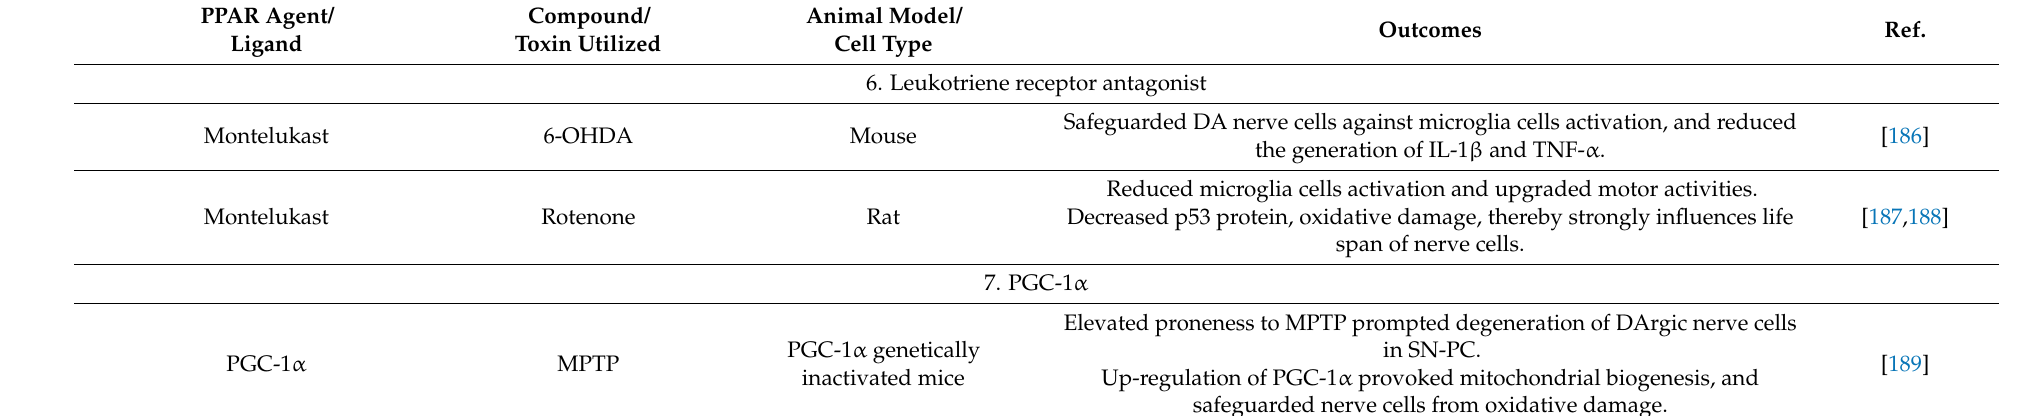
Safeguarded DA nerve cells against microglia cells activation, and reduced Mouse the generation of IL-1 β and TNF- α . Reduced microglia cells activation and upgraded motor activities. Decreased p53 protein, oxidative damage, thereby strongly influences life span of nerve